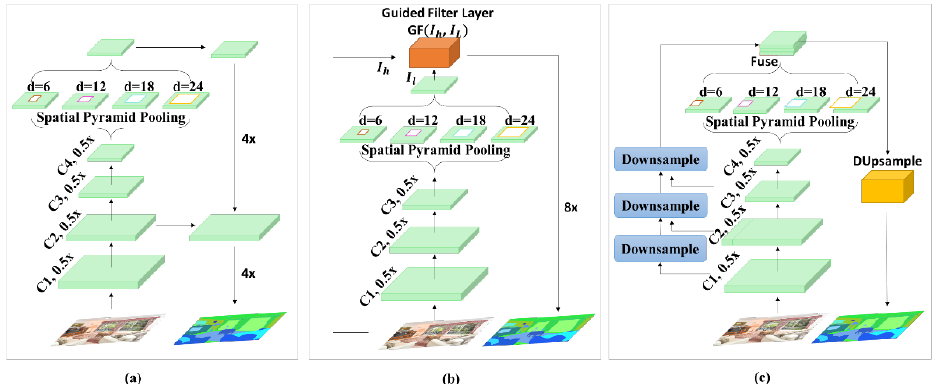
Figure 1. Overview of DeepLabv3 network architecture ( a ), implementation of guided filter layer over DeepLabv2 ( b ), and illustration of DUpsampling module employed after the last layer of DeepLabv3 ( c ).